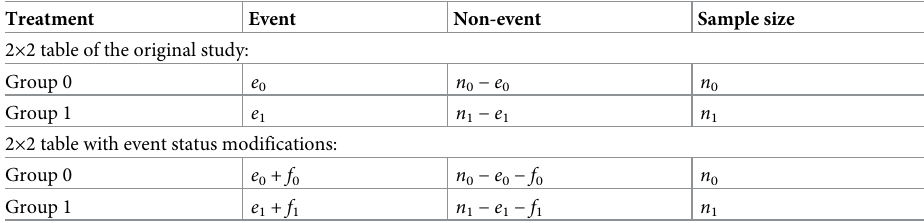
Table 1. Illustration of a 2 × 2 table and event status